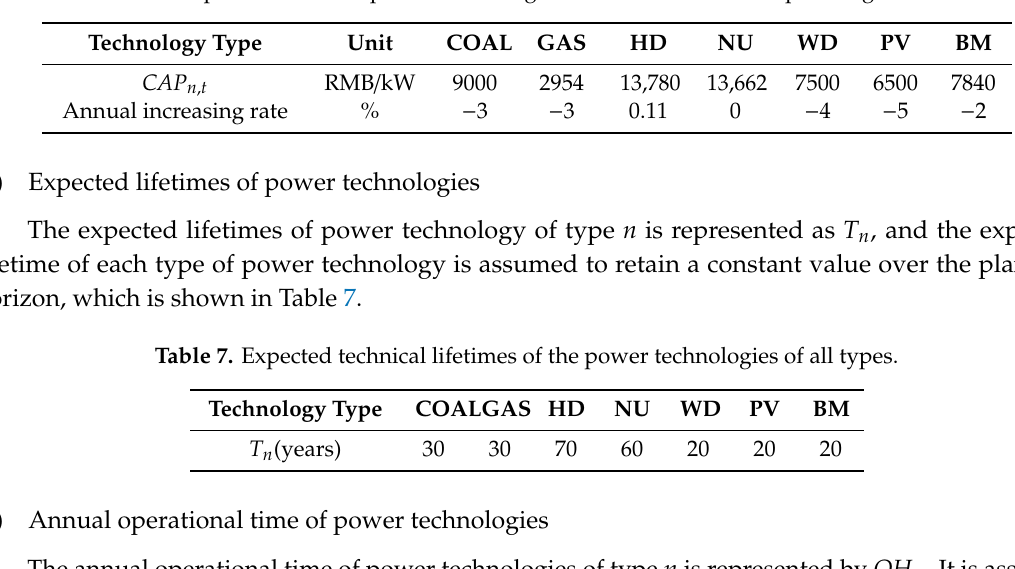
Table 6. Capital cost for the power technologies construction over the planning horizon.